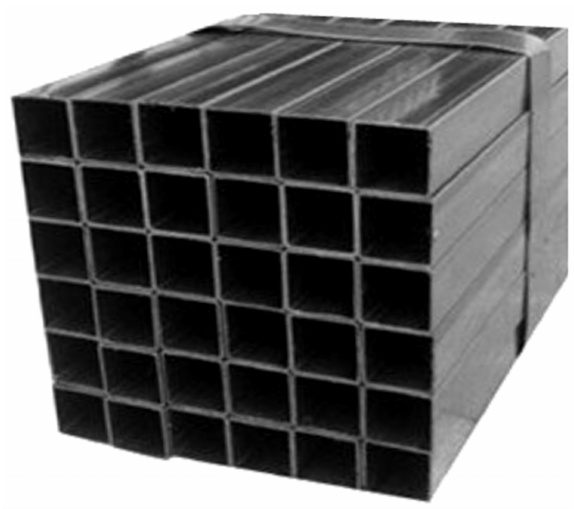
Figure 1. A package of rectangular steel sections.